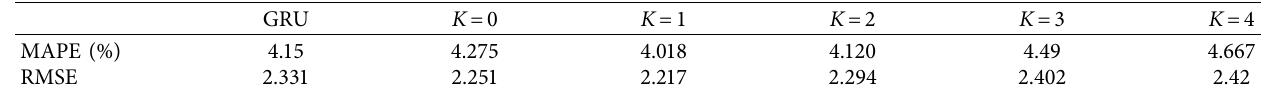
Table 3: Prediction accuracy of road Section 1 for different K values.